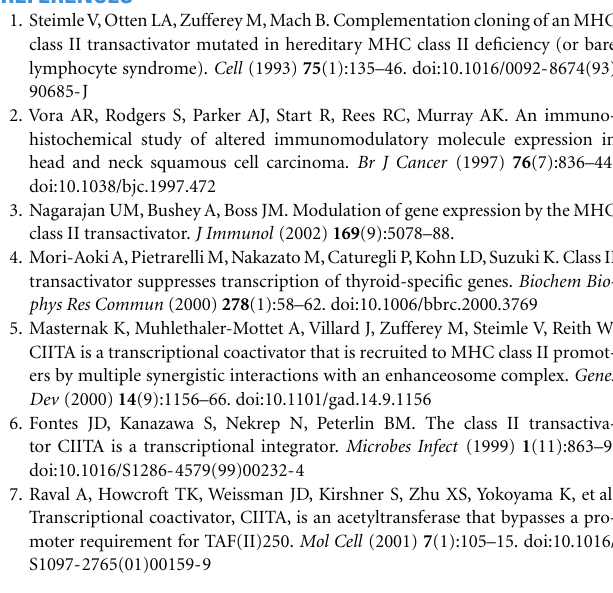
FIGURE 1 | Proposed model for the dual roles of CIITA in MHC gene transcription . (A) The induction of CIITA, in response to γ -interferon, leads to the assembly of an enhanceosome through CIITA’s interactions with CREB and the NF-Y and RFX transactivators associated with the X andY box DNA elements, respectively. In addition, CIITA interacts with chromatin modifying (CM) enzymes, contributing to chromatin remodeling. (B) Independently, CIITA recruits several components of the canonicalTFIID complex, namely